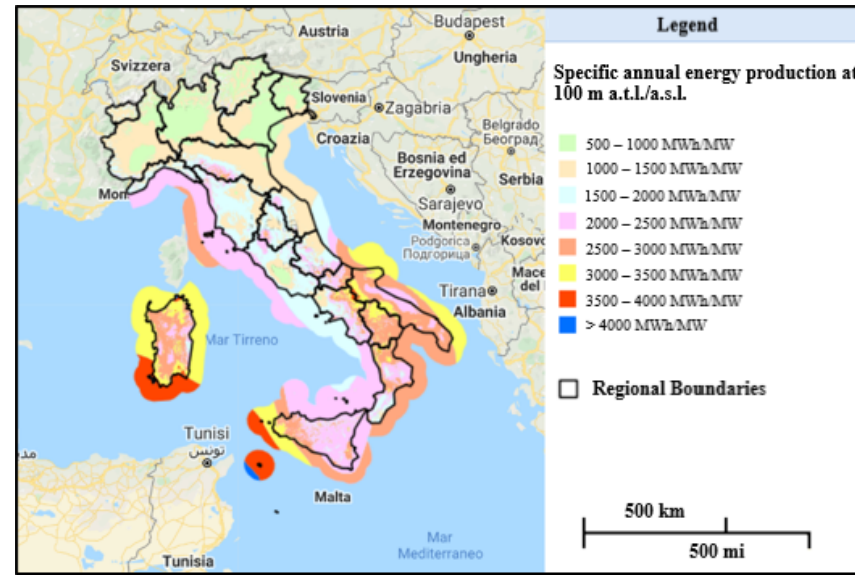
Figure 14. Wind atlas with annual energy production at 100 m, adapted from the work in